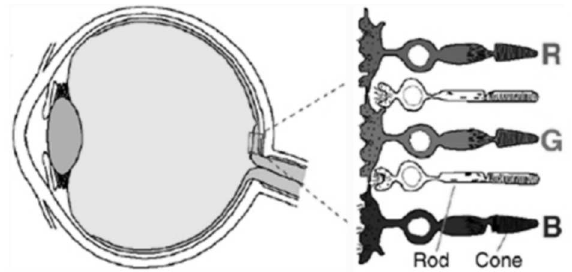
Figure 1. Photosensitive cones in the human retina (source: Mushaboomde signcom,